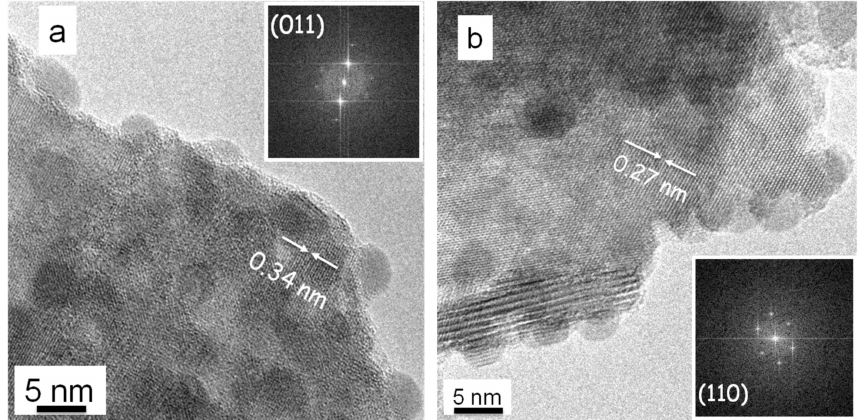
Figure 4. HRTEM images at high magnification of ( a ) sample 1 and ( b ) sample